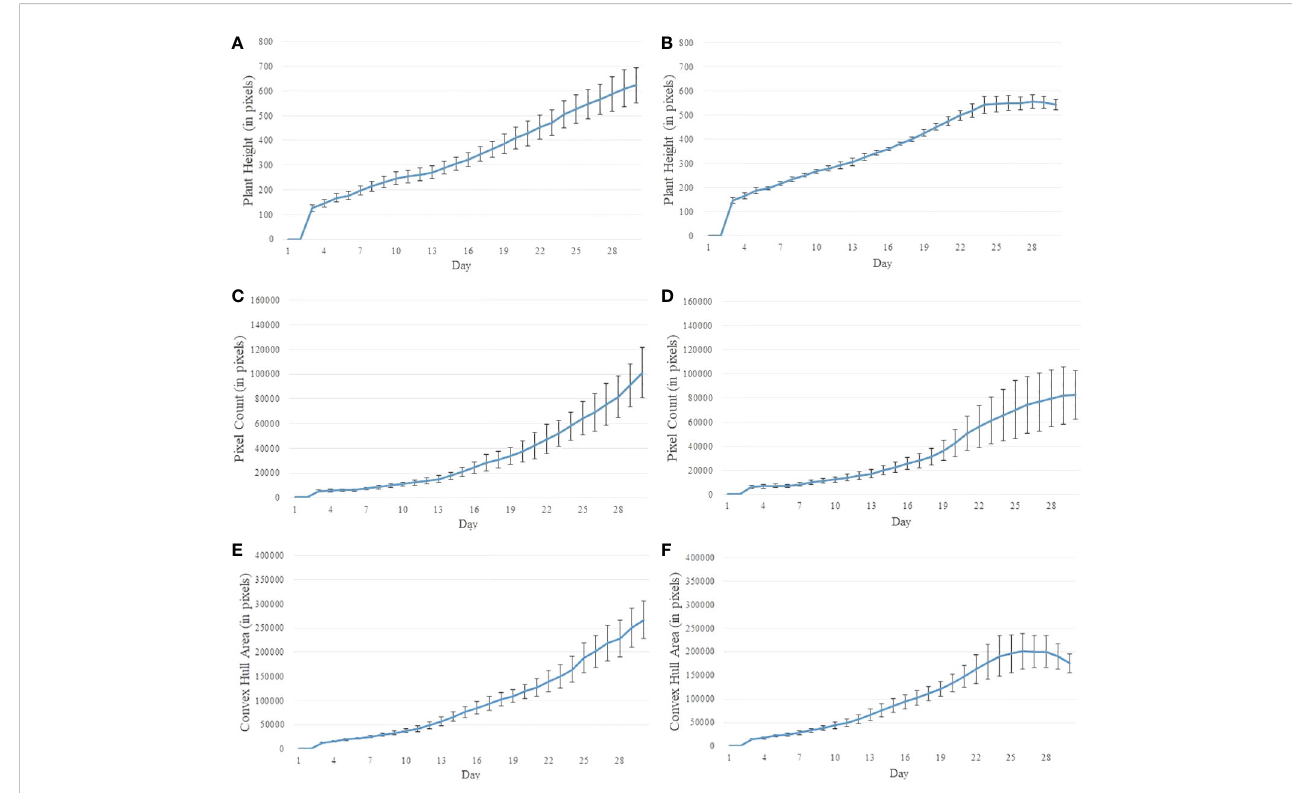
FIGURE 6 Illustration of representative phenotypic time series with mean and standard deviation using plants from Experiment 2. (A, B) plant height for control and stressed plants respectively; (C, D) plant biomass for control and stressed plants respectively; and (E, F) plant size for control and stressed plants